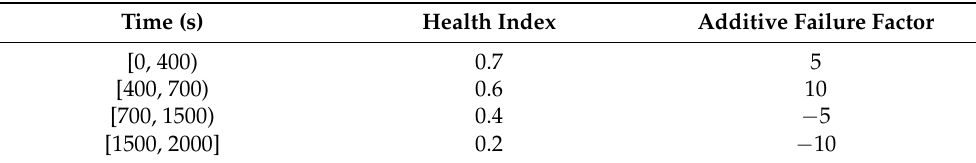
Table 2. Actuator failure factor table. Time